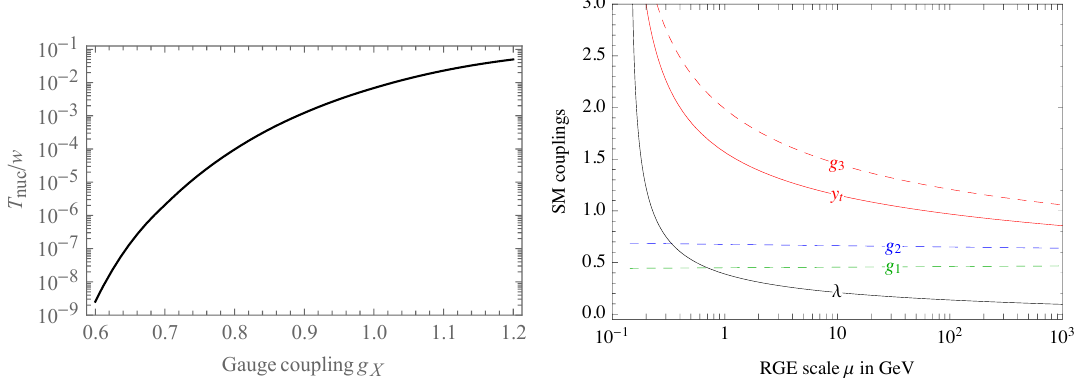
Figure 1 . Left : the nucleation temperature given by vacuum decay, ignoring the QCD phase transition. Right: 3-loop RGE running in the massless